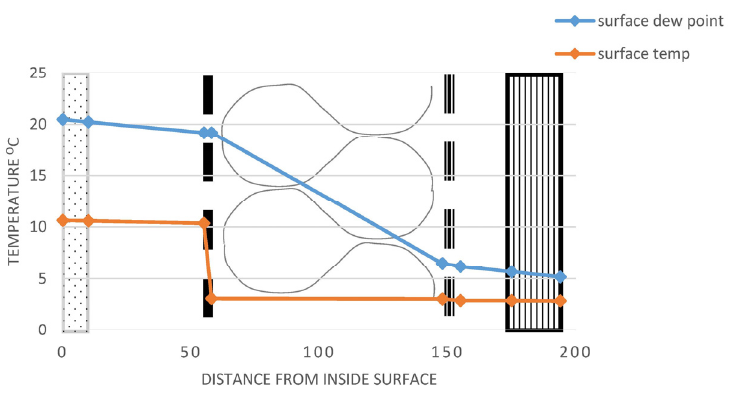
Figure 3. Interstitial condensation calculations in the test house.